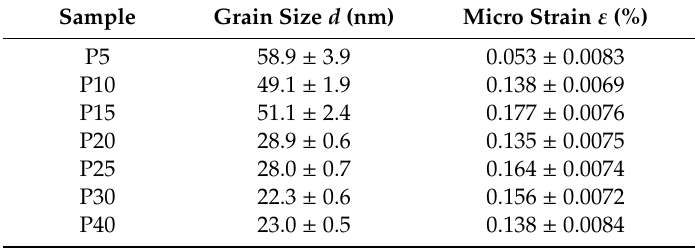
Figure 5. X-ray di ff raction (XRD) spectrum of Al-7Zn-2.5Mg-2.5Cu alloy powders after di ff erent ball milling time ( a ) the whole patterns and ( b ) localized peak patterns. Table 2. Grain size and microscopic strain with di ff erent ball milling